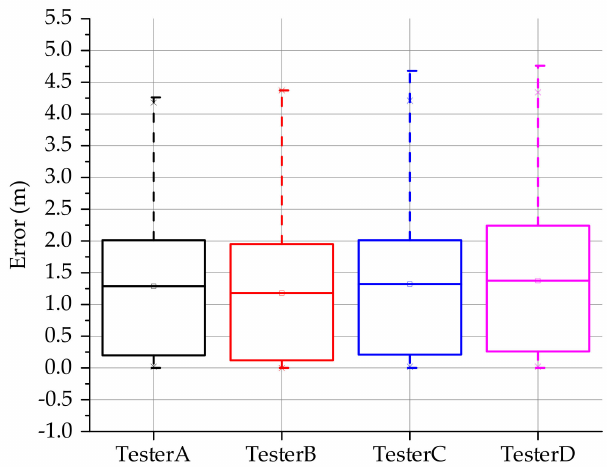
Figure 17. Adaptability of positioning model by di ff erent